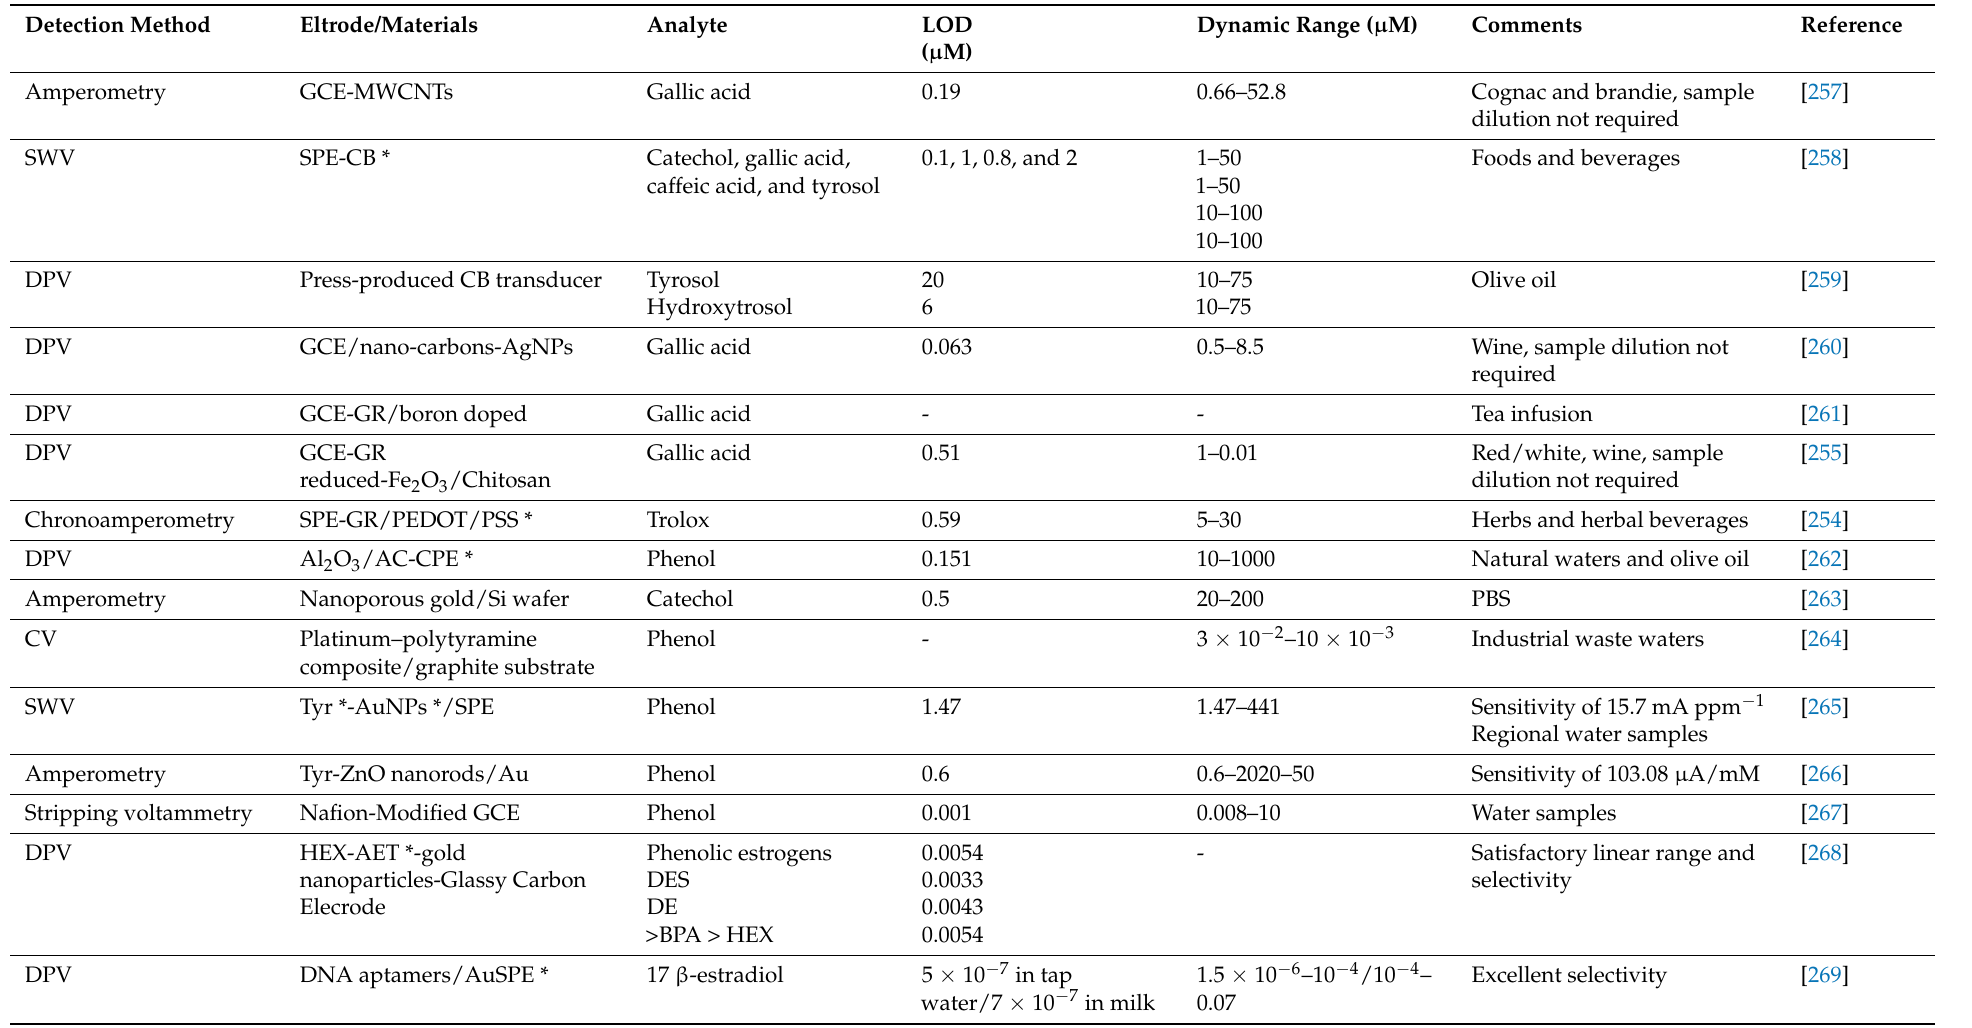
Table 8. Overview of electrochemical sensors for some emergent